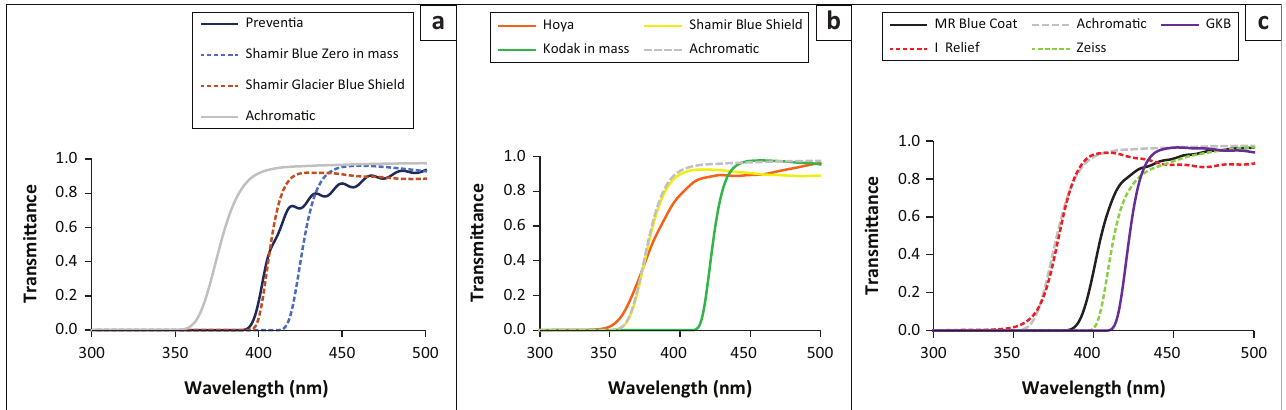
FIGURE 2: Transmittance curves for the 11 lenses (see Table 1) tested. The lenses are identified by their name and colours illustrated in parts a, b and c. The control lens is the achromatic or grey profile or curve. More harmful blue light ranges from 400 nm to 460